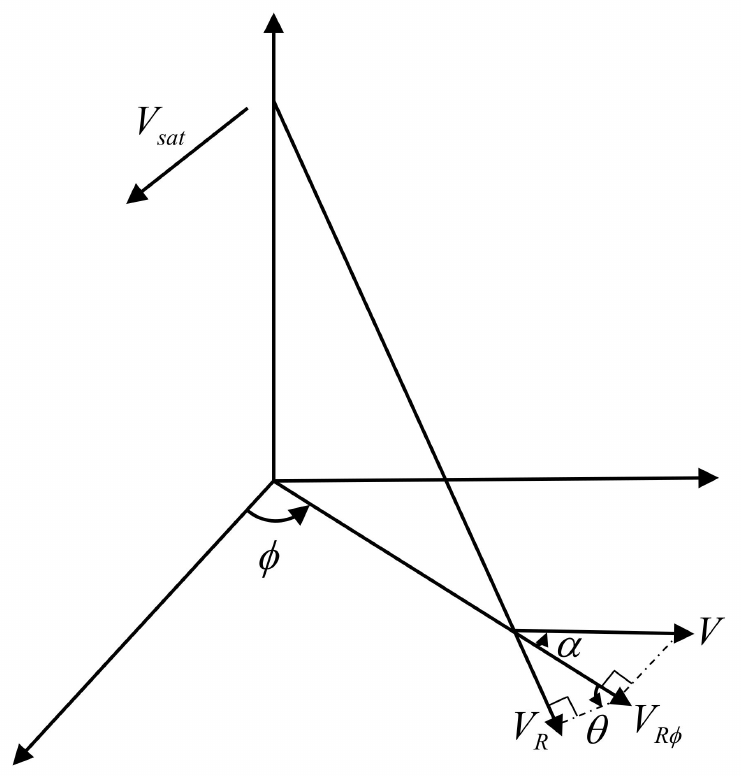
Figure 1. Schematic diagram of the Doppler scatterometer observation geometry.